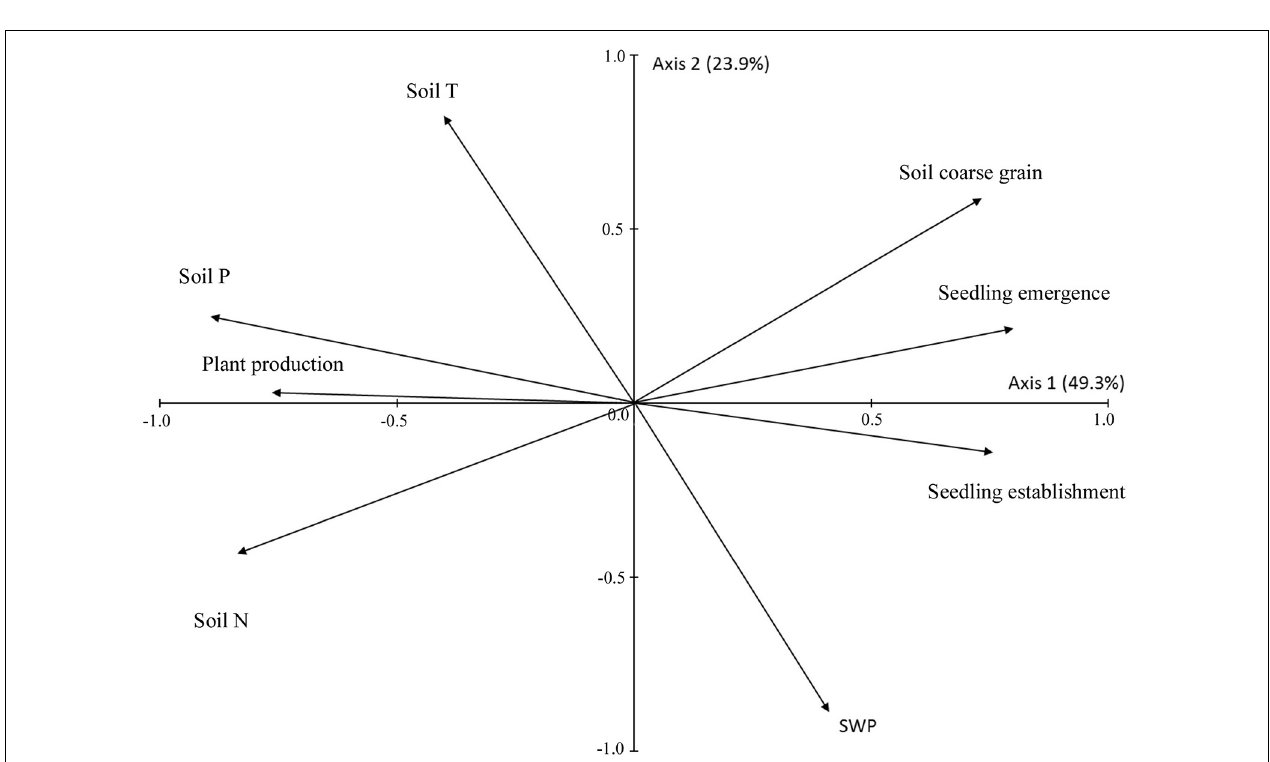
FIGURE 5 | Scores of seedling emergence, seedling establishment, plant production, soil chemistry variables and soil coarse grains ( > 6 mm) on the first two principal component (PCA) axes. Plant production is the mean production of all four species based on normalized values. The percentage of variance accounted for by each axis is in